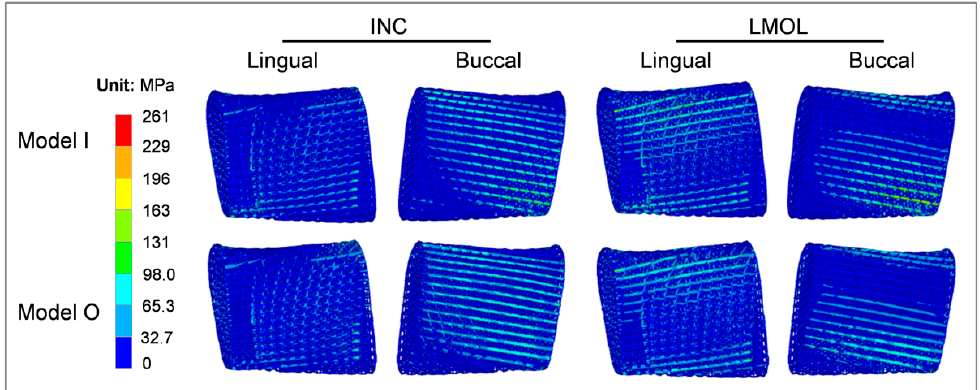
Figure 9. Von Mises stress in Model I and Model O under INC and LMOL loading.